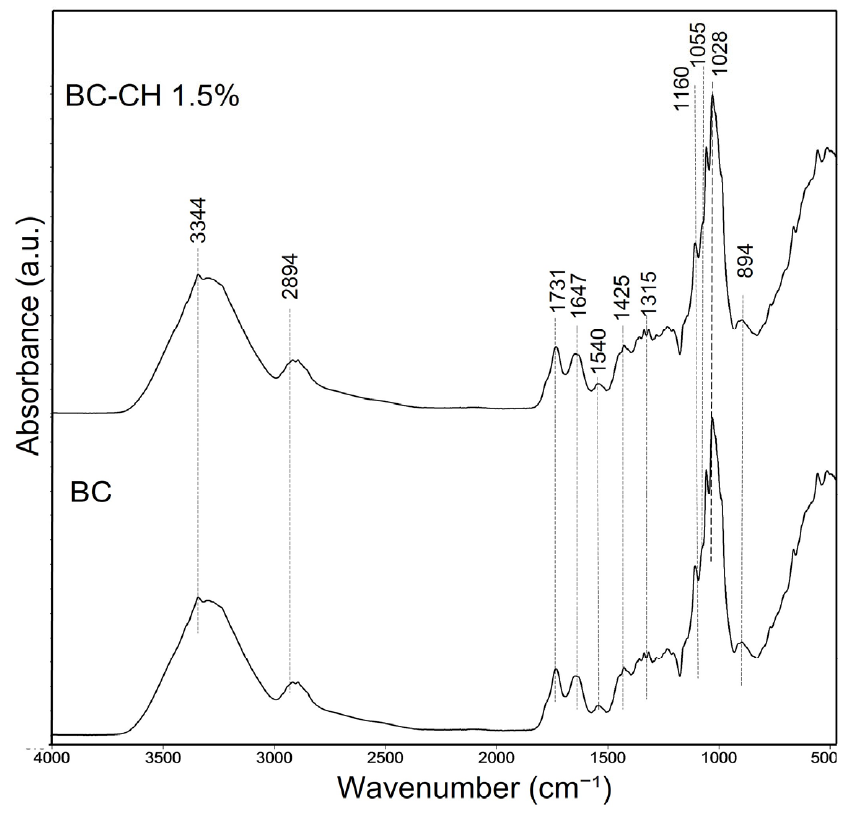
Figure 3. FTIR spectra of BC and BC-CH 1.5% films.